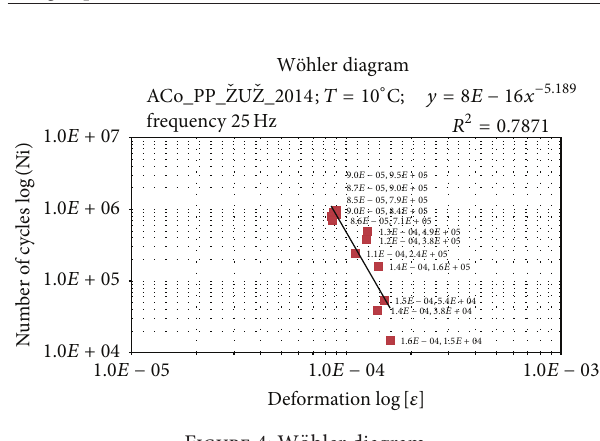
Figure 4: W¨ohler